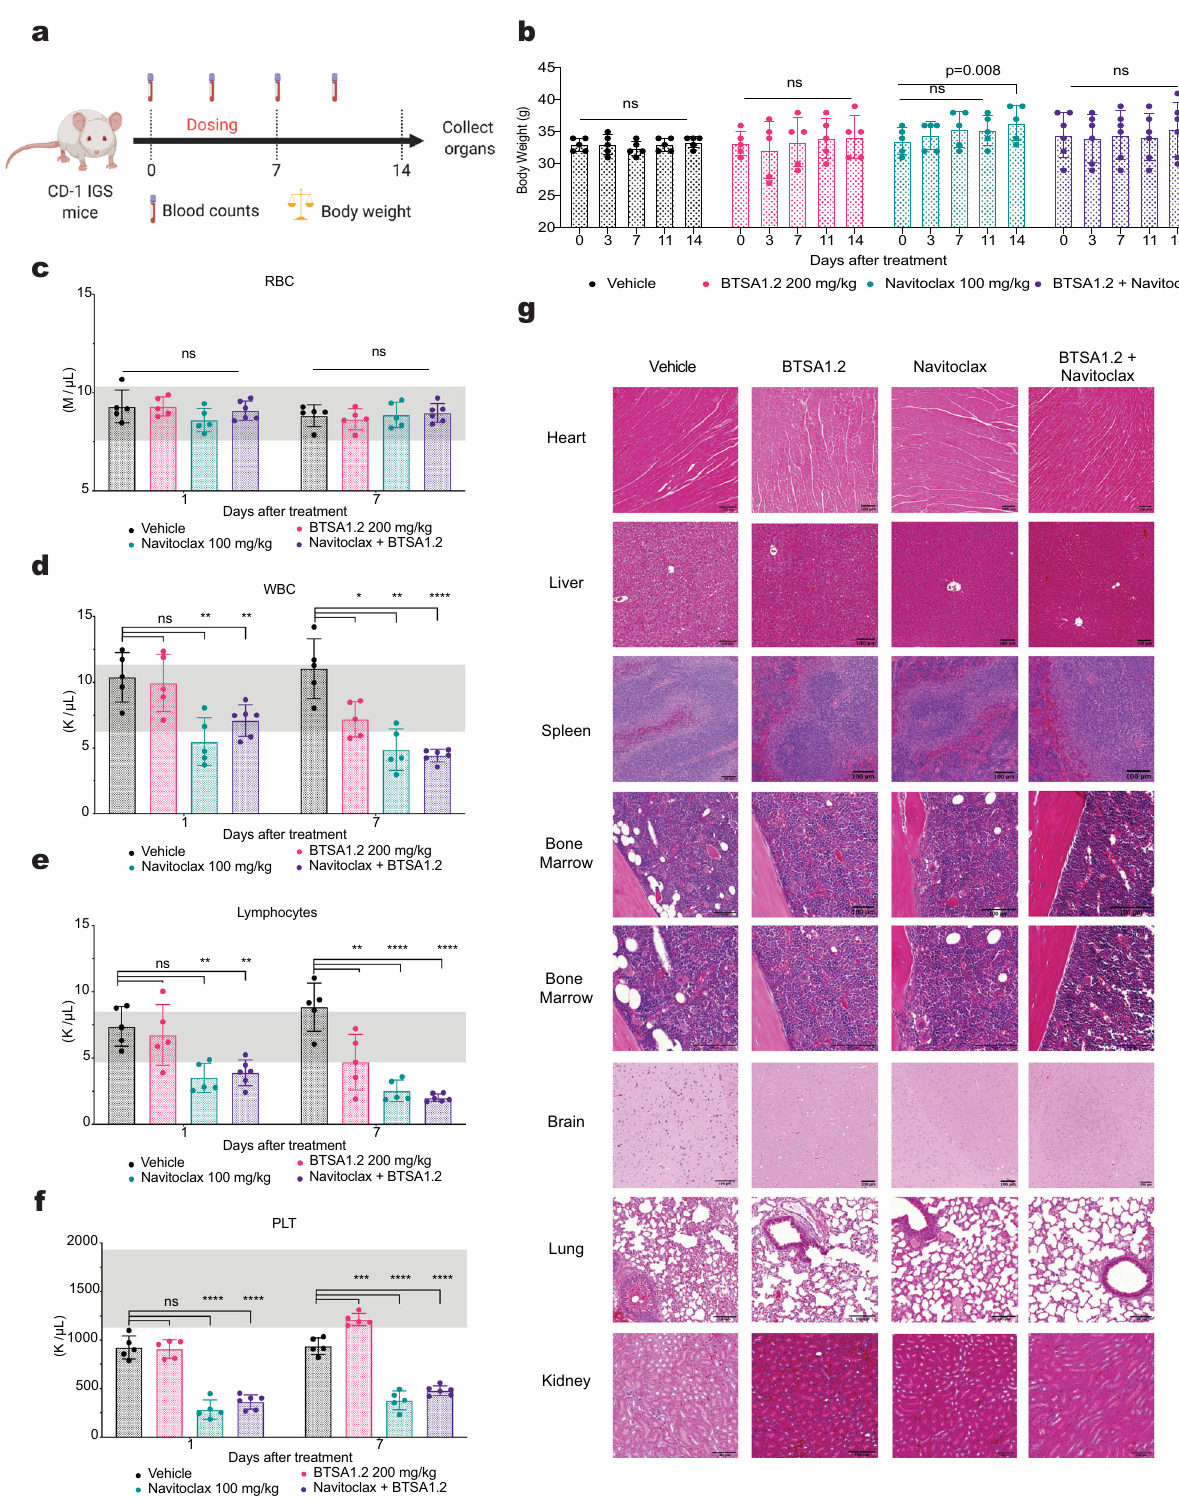
biological investigation. Having evaluated the BN C in a diverse panel of solid tumors and hematologic malignancies with different mutational background (Fig. 2a, b) and realized the signi fi cant therapeutic ef fi cacy of the combination in vivo in solid tumors (Figs. 5 and 6), we were interested in identifying genomic markers that can predict tumors' sensitivity to the drug combination treat- ment. For this, we conducted a bioinformatics analysis using gene